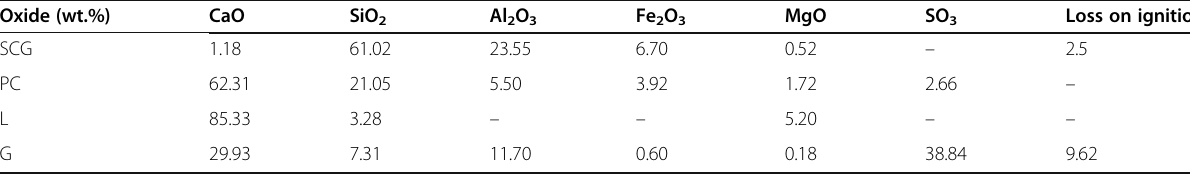
Table 1 Chemical composition and loss on ignition of precursors Oxide